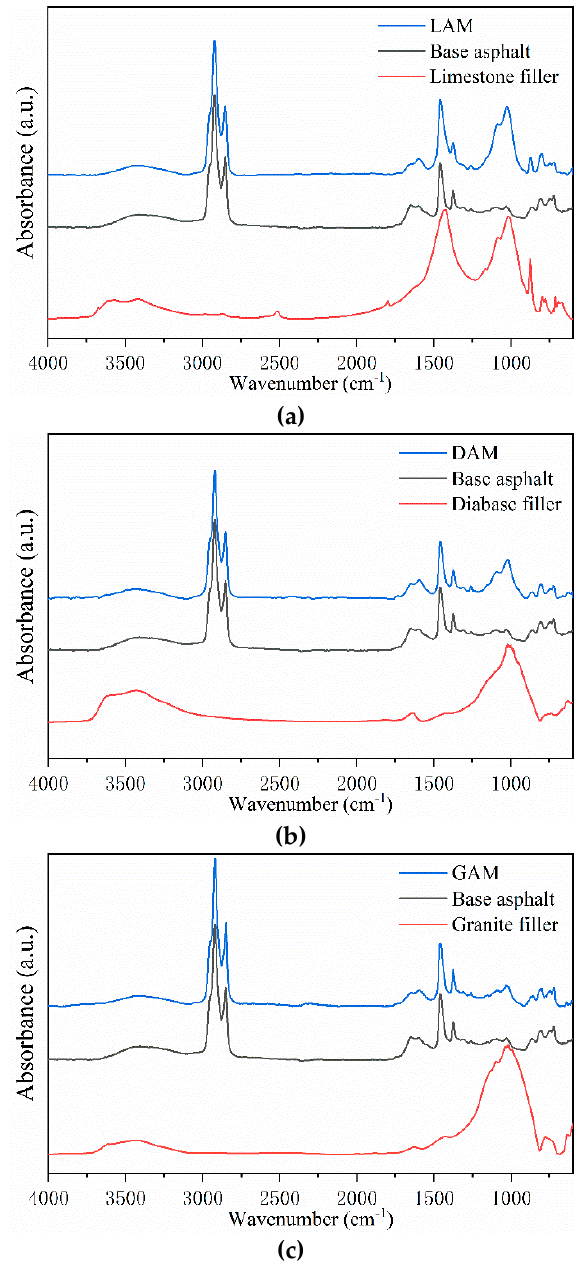
Figure 4. Infrared spectrum of the base asphalt binder, fillers, and asphalt mastics. ( a ) Limestone; ( b ) Diabase; ( c ) Granite.